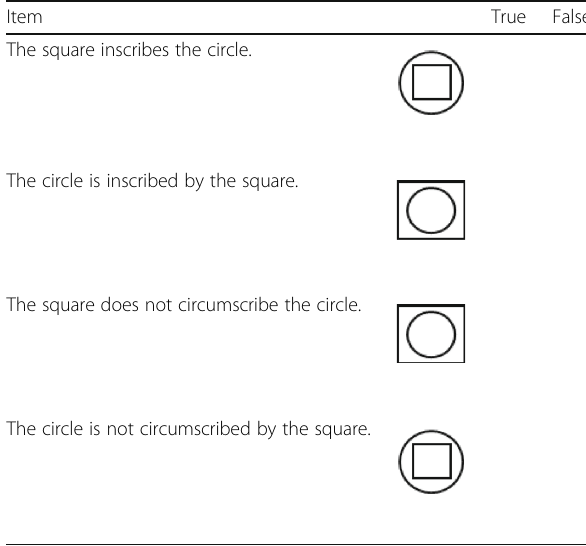
Table 1 Sample items of the adapted grammatical reasoning test